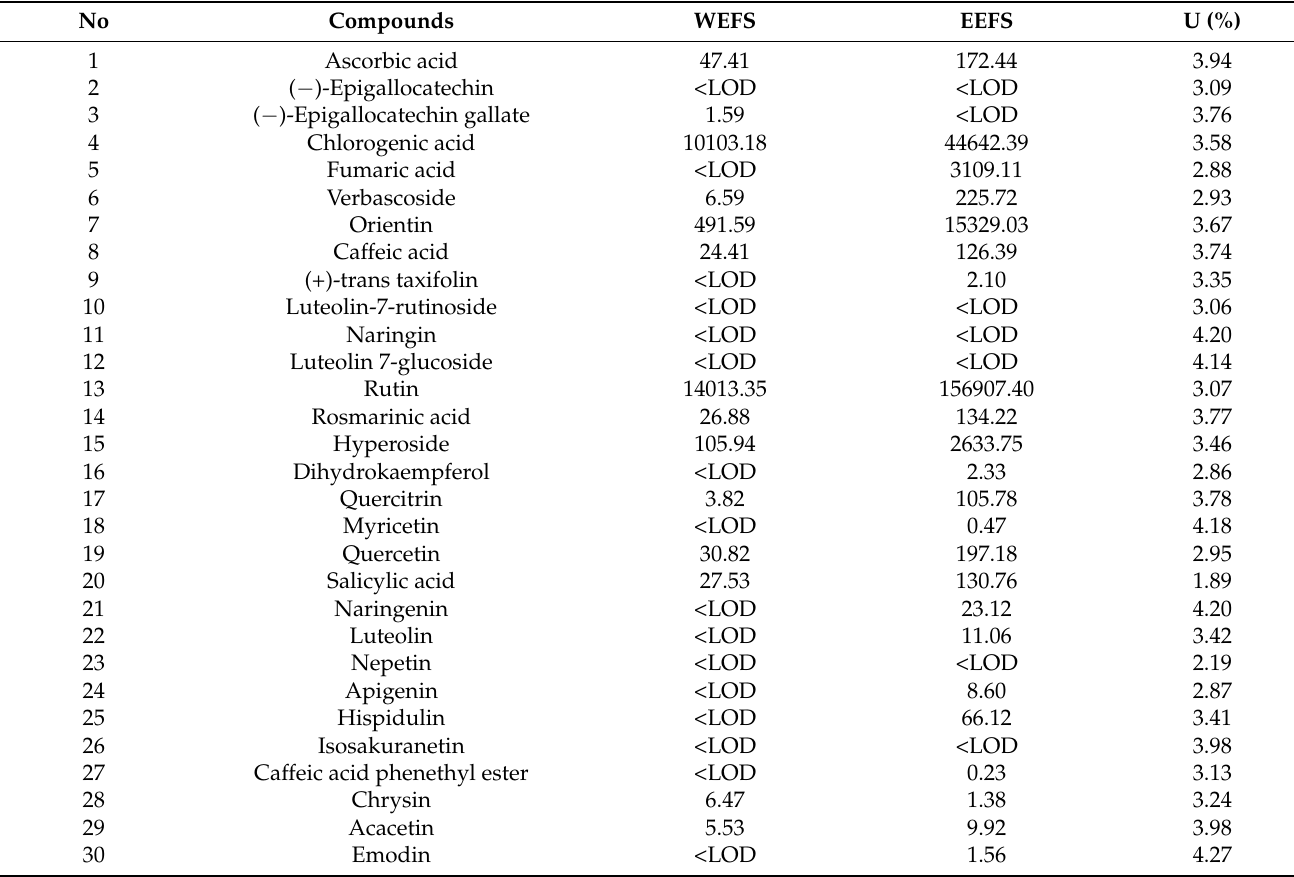
Table 3. Liquid chromatography-high-resolution mass spectrometry (LC-HRMS) analysis of EEFS and WEFS (EEFS: evaporated ethanolic extract of aerial parts kınkor ( Ferulago stellata ); WEFS: lyophilized water extract of aerial parts of kınkor ( Ferulago stellata